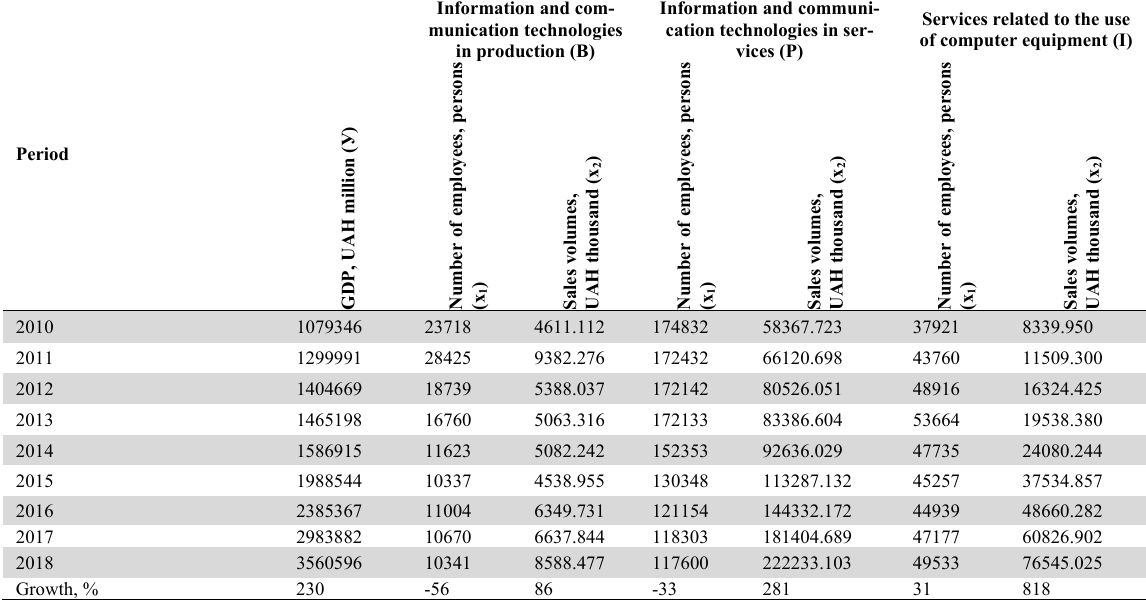
Dynamics of indicators of enterprises development in the digital technologies sector in Ukraine